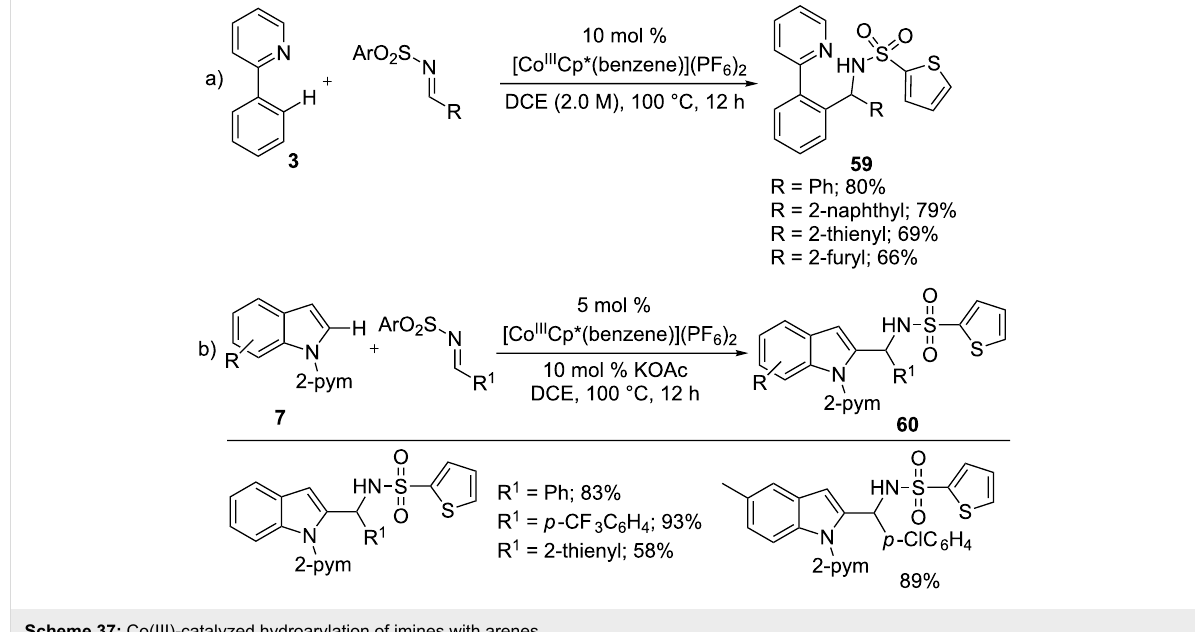
Scheme 37: Co(III)-catalyzed hydroarylation of imines with arenes.